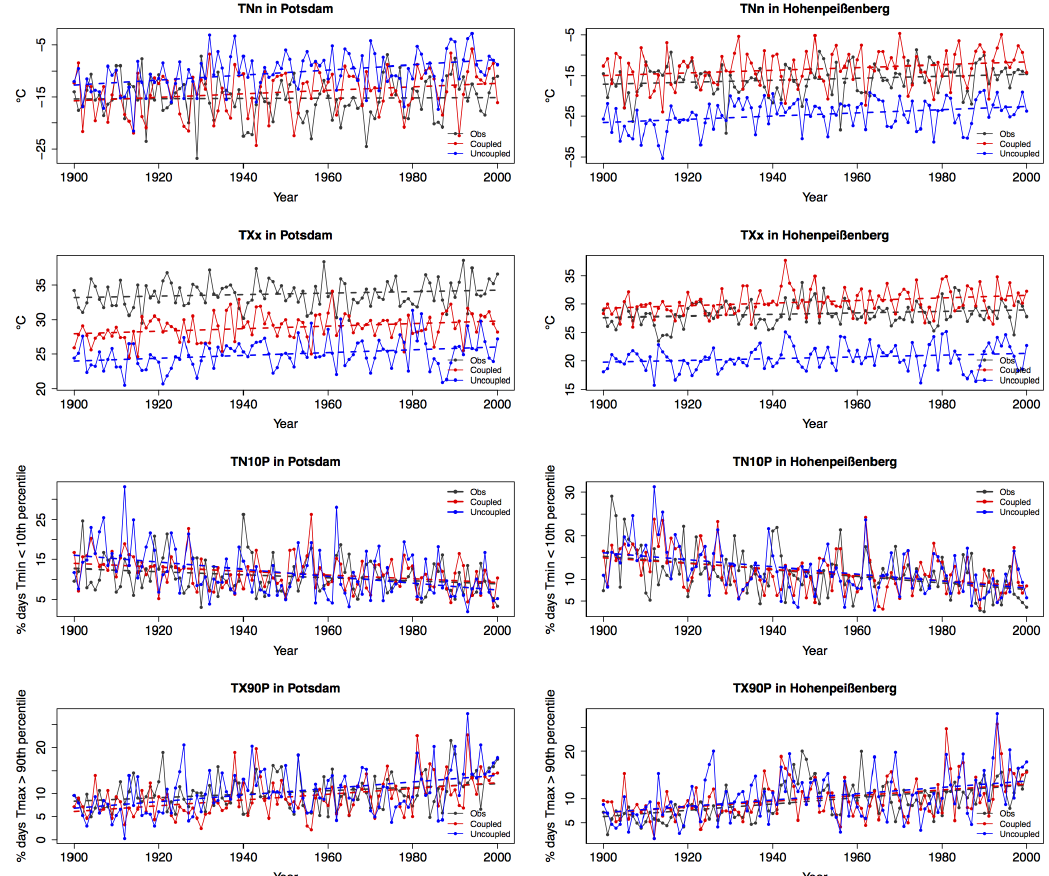
Figure 14. Temporal evolution of four climate change indices at two stations in Germany, Potsdam (81m) and Hohenpeißenberg (977m). TNn represents the annual minimum value of daily minimum temperature; TXx represents the annual maximum value of daily maximum temperature; TX90p represents the percentage of days when the maximum temperature is above the calendar-day 90th percentile centred on a 5d window for the base period 1961–1990; and TN10p represents the percentage of days when the minimum temperature is below the calendar-day 10th percentile centred on a 5d window for the base period 1961–1990. Linear trends are shown as dashed